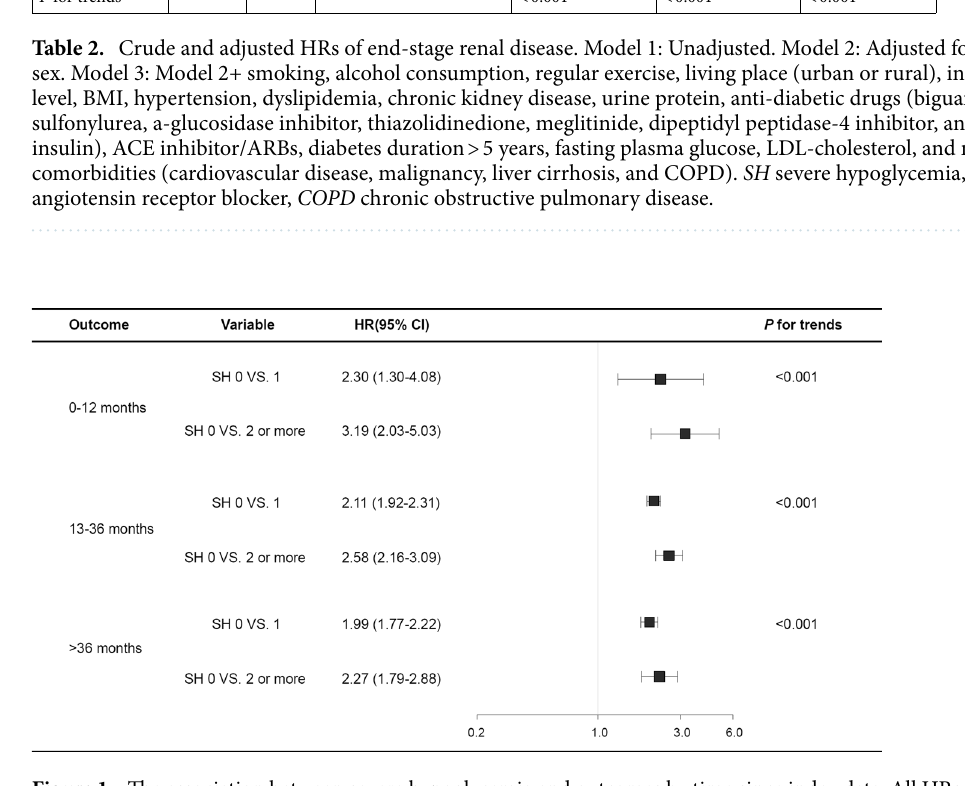
Figure 1. The association between severe hypoglycemia and outcomes by time since index date. All HRs adjusted for covariates including age, sex, smoking, alcohol consumption, regular exercise, living place (urban or rural), income level, BMI, hypertension, dyslipidemia, chronic kidney disease, urine protein, anti-diabetic drugs, diabetes duration, fasting plasma glucose, LDL-cholesterol, and major comorbidities (malignancy, liver cirrhosis, and chronic obstructive pulmonary